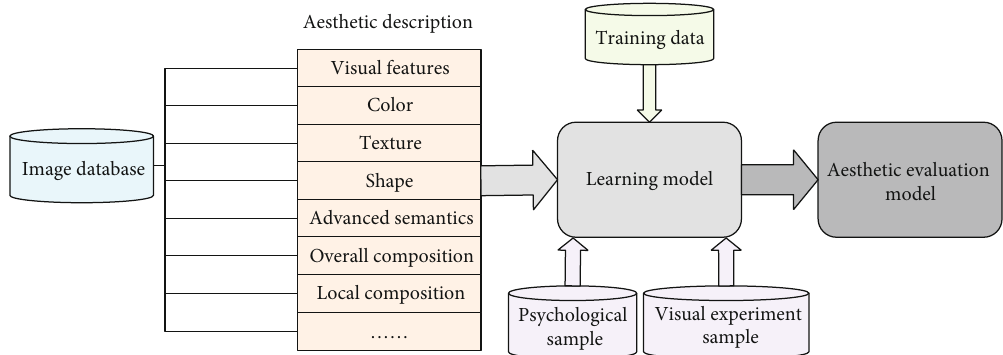
Figure 3: Overall architecture of the image aesthetic evaluation